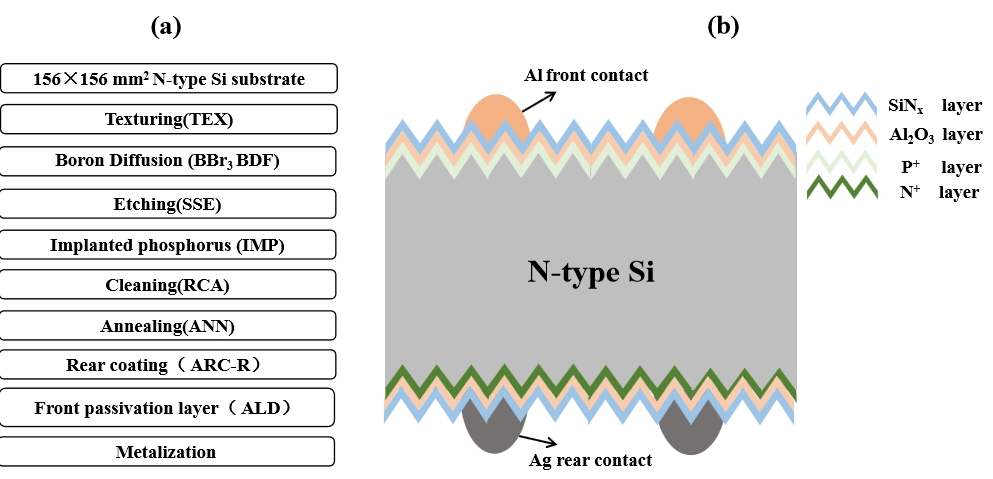
Figure 1. ( a ) The manufacturing process; ( b ) the structure diagram of N-PERT solar cells. The firing-through Al paste used in this paper consists of Al powder (74 wt%),